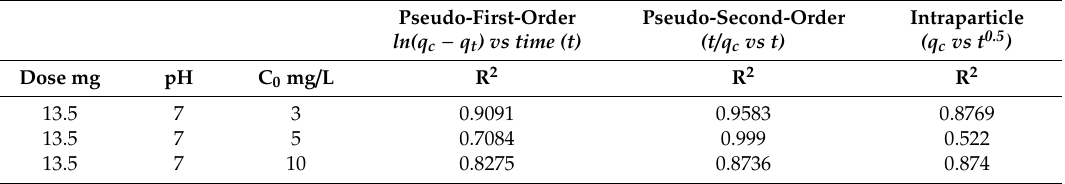
Figure 10. The plot of pseudo-second-order kinetic for Al 3 + adsorption on hybrid CNTs. Table 6. Adsorption kinetics and correlation coefficient.